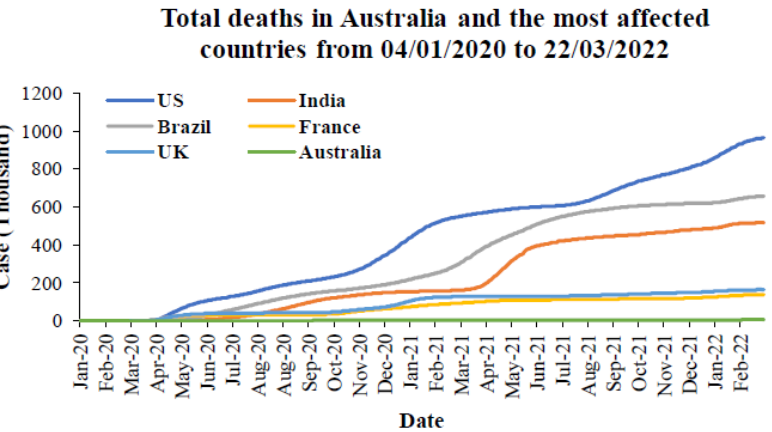
Figure 13. The comparison of severity during the peaks of Delta and Omicron outbreaks in: ( a ) Aus- tralia, ( b ) France, ( c ) the UK, and ( d ) the US.